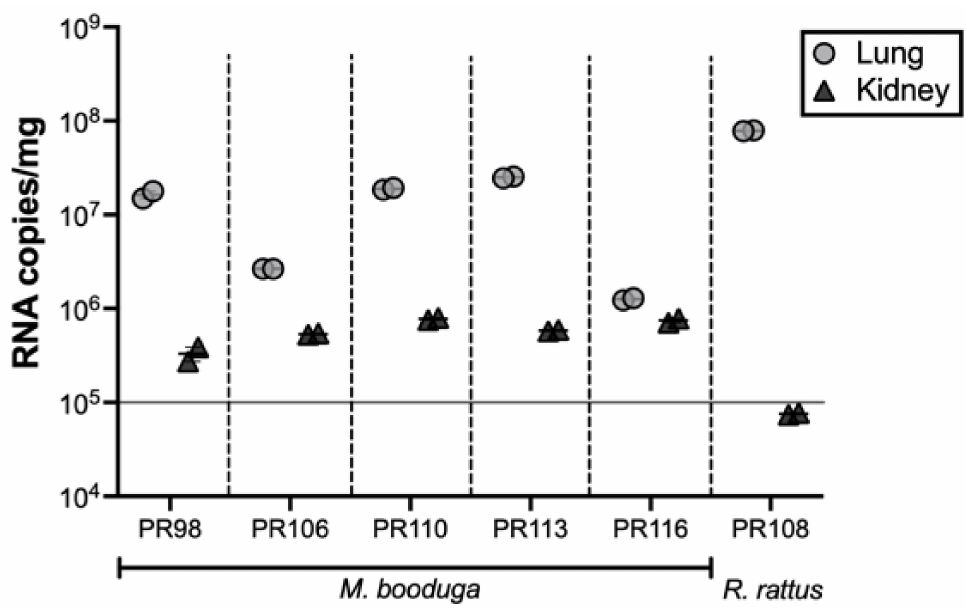
Figure 4. Viral RNA copy numbers in lung and kidney tissues of hantavirus genome-positive rodents. Tissues from M. booduga and R. rattus were examined by quantitative real-time PCR using the Lanka virus primer set and the SA108 primer set, respectively. The two markers of each sample show the two replicated runs of the same cDNA sample, and the error bars representing the standard error and the median of the duplicates are shown for each